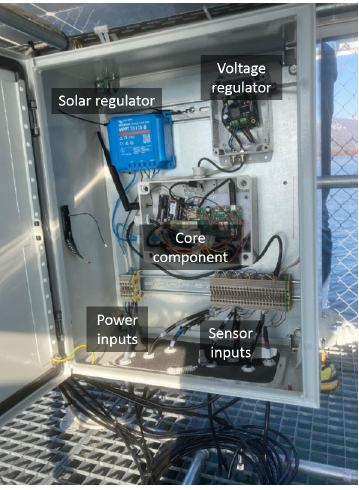
Figure 7. The main unit